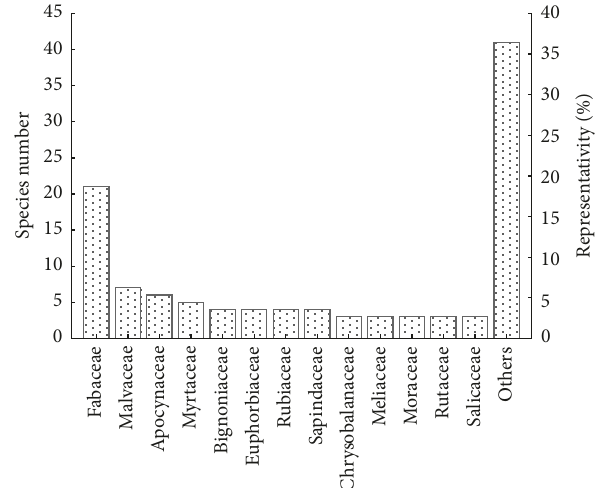
Figure 3: The most representative families in species number of the Parque Estadual Mata Atlˆantica (PEMA), Goi´as,